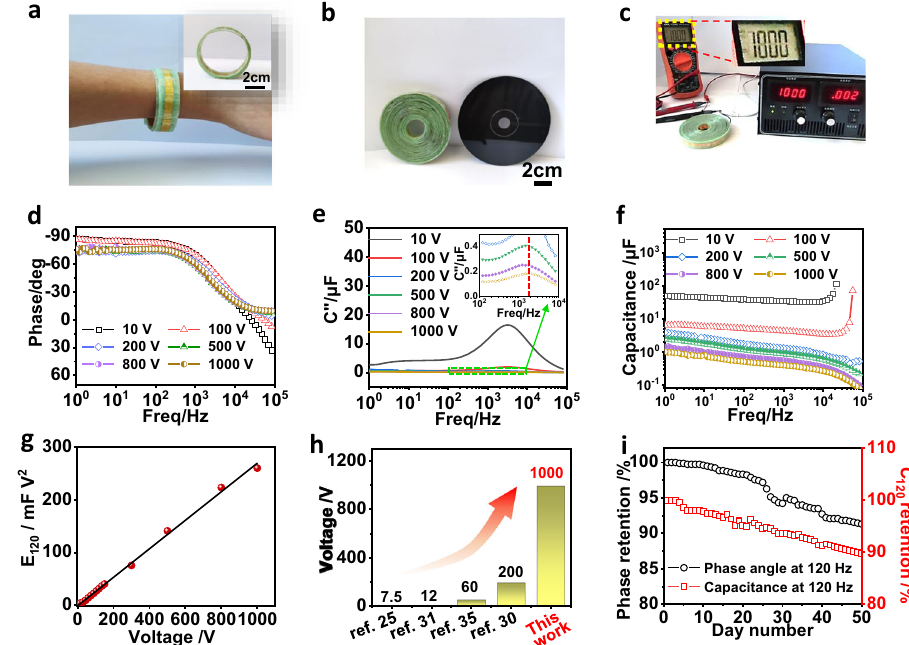
Fig. 5 | Filtering capacitors integrated with ACPECs in large-scale. The photo- graphsof( a )67-ACPECs,and( b )comparingthesizeofscrolled670-ACPECswitha disk. c Photograph of 670-ACPECs charged to 1000V at the current density of 8mAcm − 2 . d − f The electrochemical performance of fi ltering capacitors integrated withvariousnumberof ACPECs. d Plotsofphaseangleversusfrequency. e Plotsof the imaginary part of capacitance ( C ” ) versus frequency, inset: the frequency cor- responding to the maximum C ” of 340-ACPECs (green dotted line), 540-ACPECs